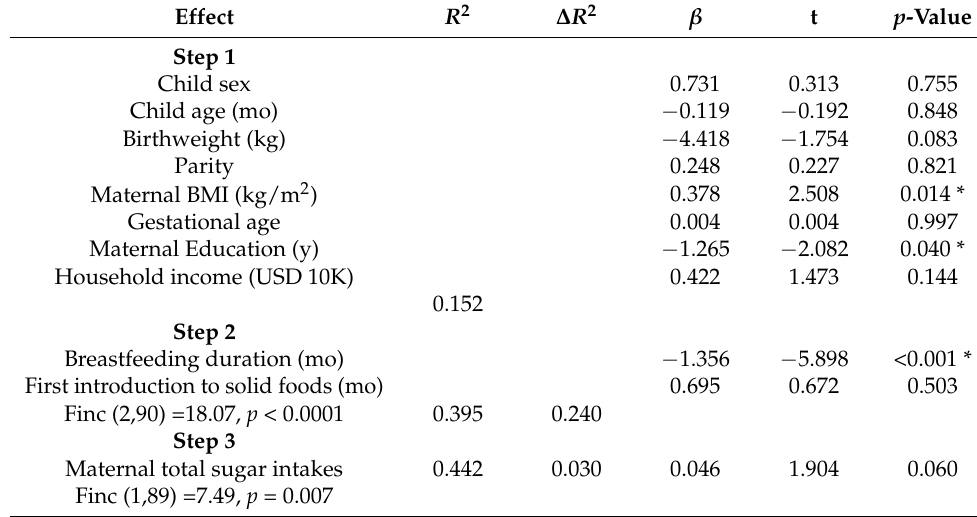
Table 2. Hierarchical regression model of maternal total sugar intakes ( R 2 , change statistics [ ∆ R 2 ], and regression coefficients [ β ]) predicting infant added sugar intakes ( n =